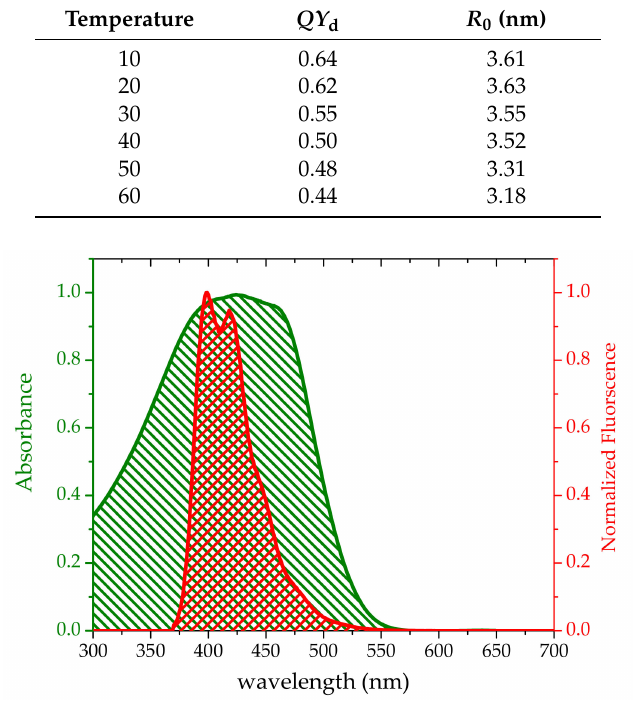
Figure 7. Overlap between fluorescence spectrum of HOTF (10 µ M) and absorption spectrum of TCP (10 µ M) at 20 ◦